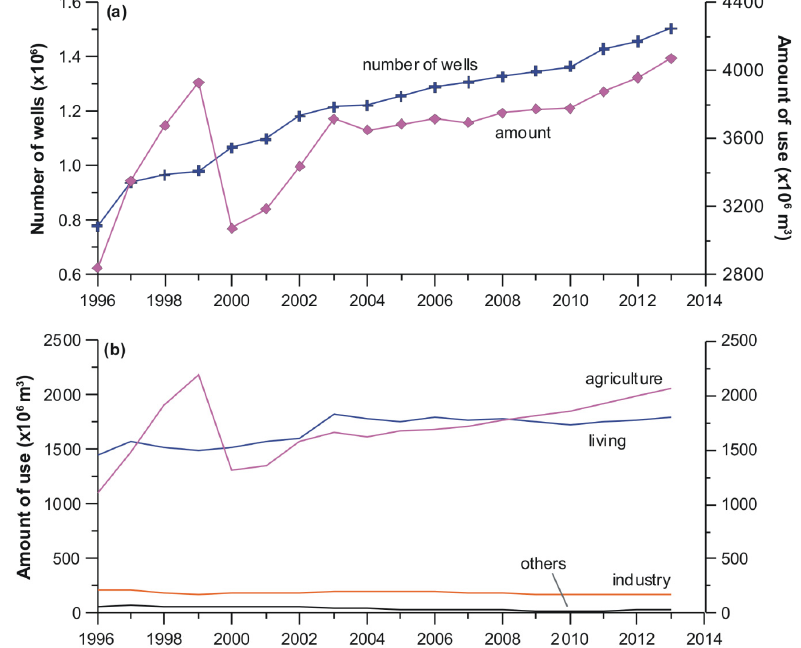
Figure 2. ( a ) Number of groundwater wells installed and total amount of groundwater use in Korea for 1996–2013; and ( b ) amount of water use by agriculture, domestic, and industry. Data are from the National Groundwater Information Center (www.gims.go.kr).